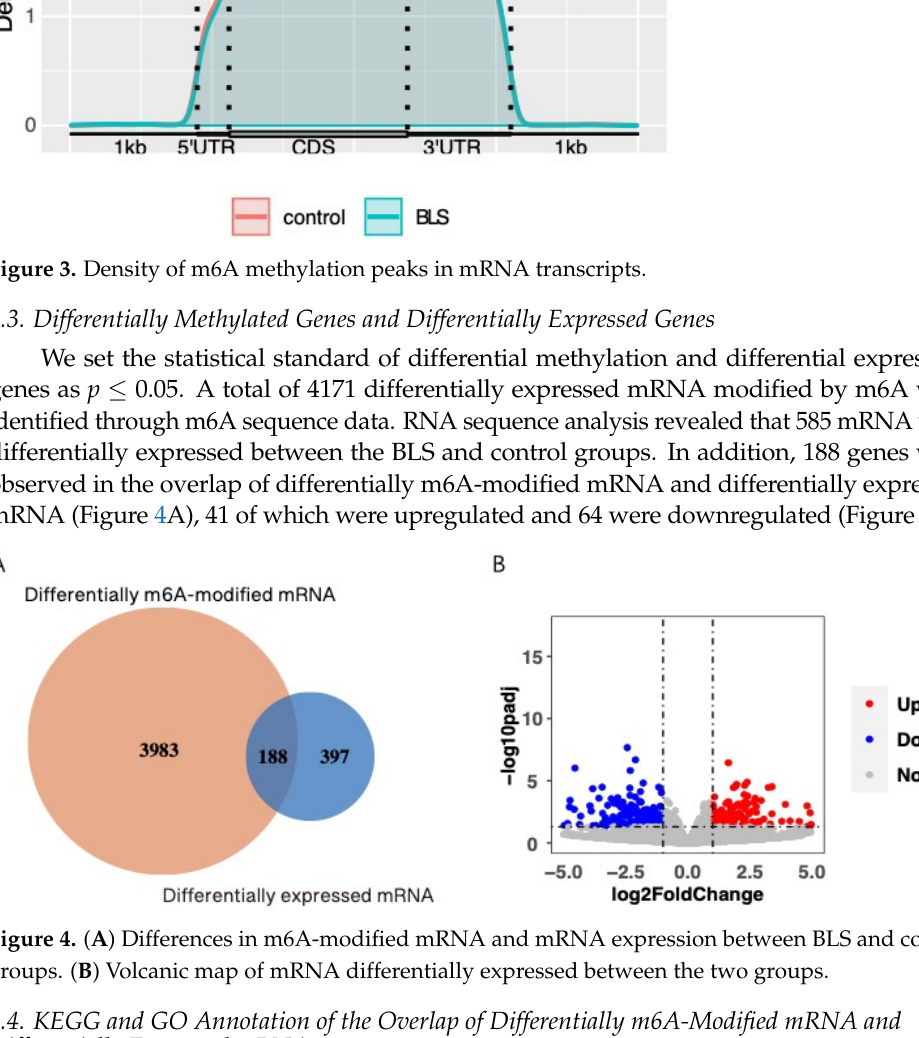
Figure 4. ( A ) Differences in m6A ‐ modified mRNA and mRNA expression between BLS and control groups. ( B ) Volcanic map of mRNA differentially expressed between the two groups.